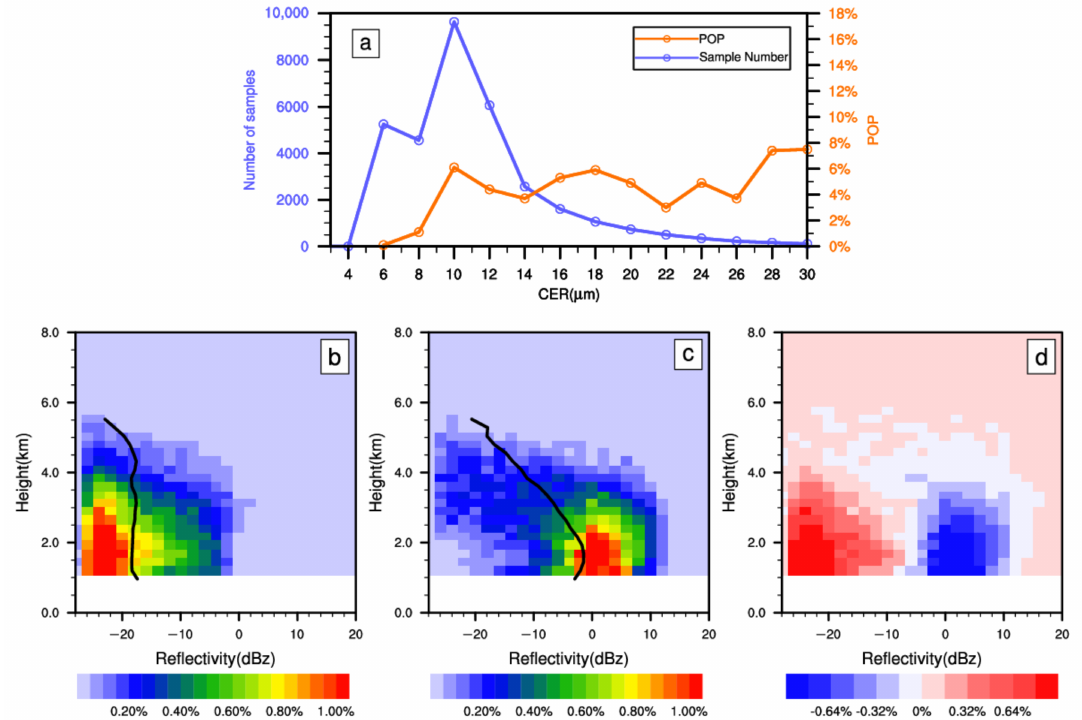
Figure 11. ( a ) Sample number (blue line) and probability of precipitation (orange line) as a function of the cloud effective radius. Normalized contoured frequency by altitude diagrams of radar reflectivity for single-layer water clouds for ( b ) non-precipitating clouds, ( c ) precipitating clouds, and ( d ) their differences (non-precipitating clouds minus precipitating clouds). The black lines in parts ( b ) and ( c ) are the mean vertical profile of reflectivity for non-precipitating clouds and precipitating clouds, respectively. CER = cloud effective radius; POP = probability of